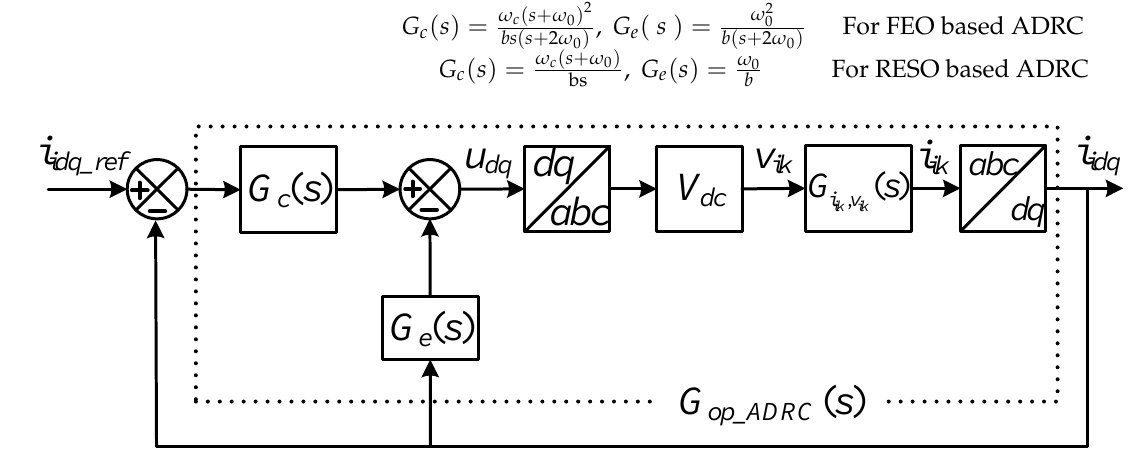
Figure 8. Block diagram of the current control of an L or LCL filter type GcI with either FESO- or RESO-based linear ADRC.